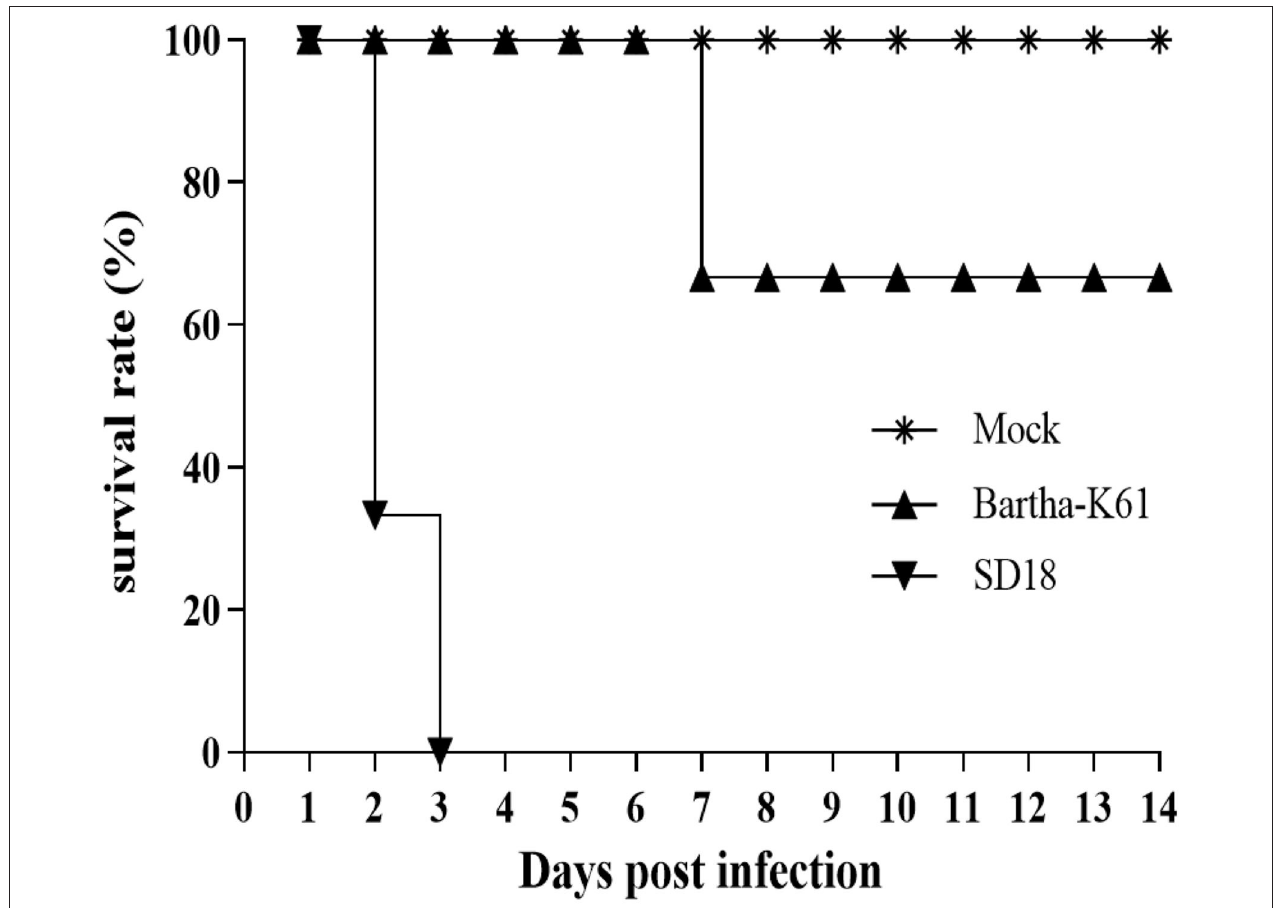
FIGURE 1 | Survival curves of PRV-infected cats. Cats that were 10 weeks old were infected with Bartha-K61, SD18, or PBS. Clinical signs of disease were observed daily. In the Bartha-K61-infected group, one cat exhibited anorexia, anxiety, and crying and euthanized at the end of expeirence. Fourteen days later, the cats were euthanized with sodium nitrite.